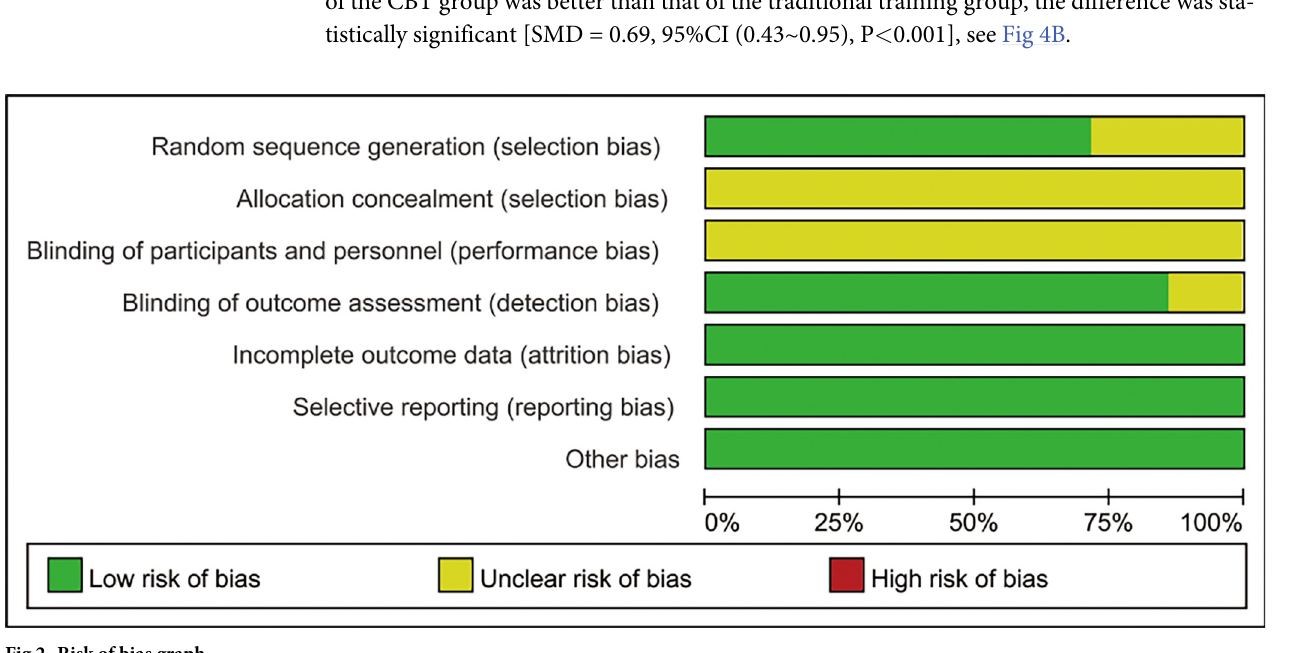
Ability of critical thinking and innovation. Three RCTs [17,20,23] reported the impact of CBT on nurses’ ability of critical thinking and innovation. The combined results showed no heterogeneity between studies (I 2 = 0%, P = 0.79), so the fixed effects model was used for meta-analysis. The combined results showed that the ability of critical thinking and innovation of the CBT group was better than that of the traditional training group, the difference was sta-